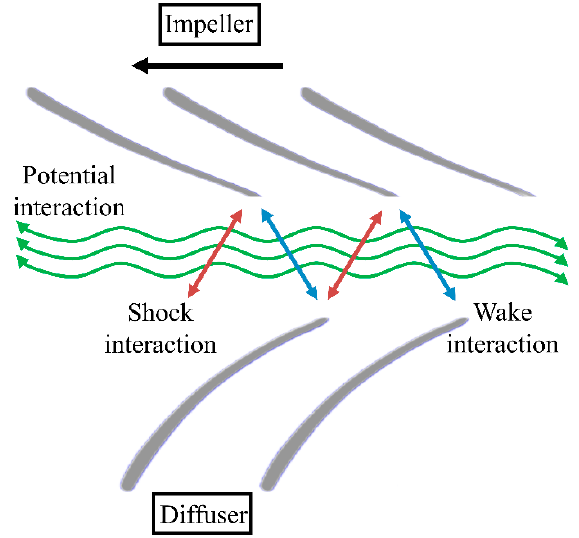
Figure 8. Schematic of rotor–stator interaction.